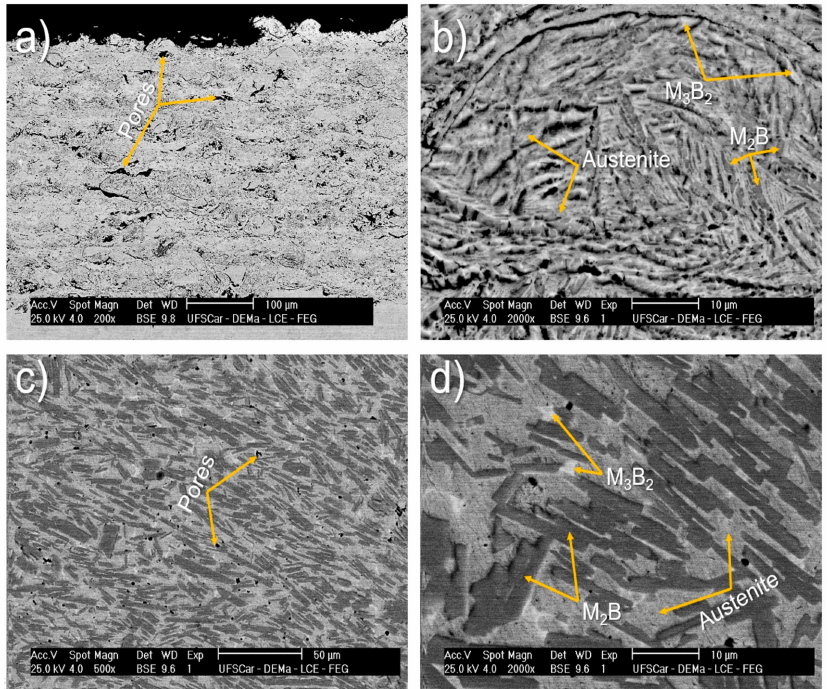
Figure 8. SEM backscattered electron image of 63.5Fe25Cr7Ni4.5B ( a , b ) HVOF coatings and ( c , d ) deposit produced by spray deposition. Phases were identified based on local EDS analyses and the thermodynamic calculation results. As the M 3 B 2 borides are rich in Mo they appear as bright phases in the images. M 2 B borides appear as dark phases since M =